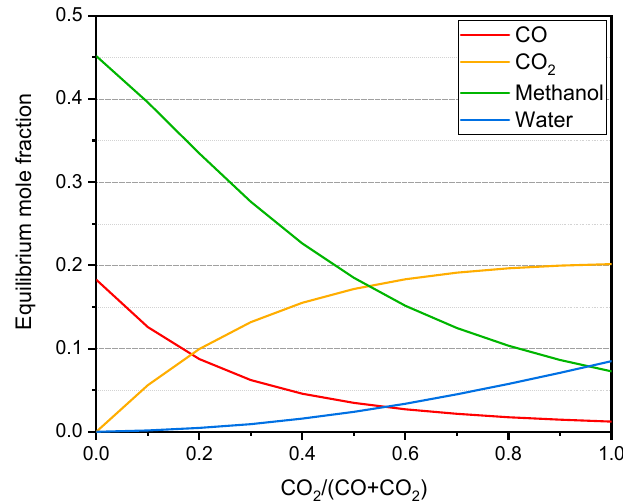
Figure 6. Equilibrium composition for the methanol synthesis reaction depending on the syngas composition at 230 °C and 50 bar. M module ([H 2 − CO 2 ]/[CO + CO 2 ]) equal to 2. Calculated using Aspen Plus software (Aspen Plus V11, Aspen Technology, Inc., Bedford, MA, USA, 2019).